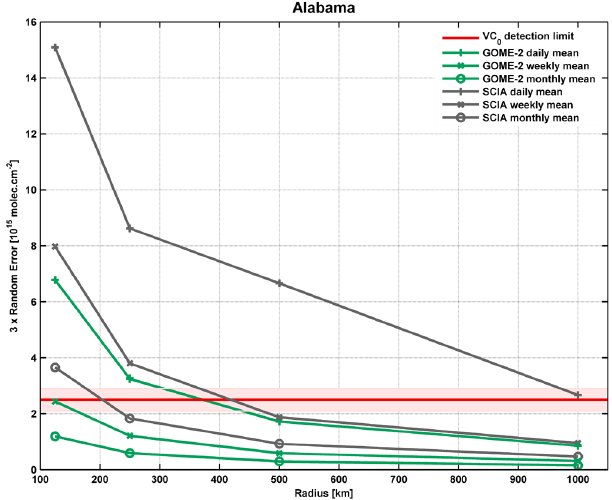
Fig. 11. Detection limit of the SCIAMACHY and GOME-2 daily, weekly and monthly averaged H 2 CO vertical columns, in function of the radius considered around Alabama (southeastern US) in Au- gust 2007. The red line shows the IMAGES correction in the remote Pacific, considered as the background detection